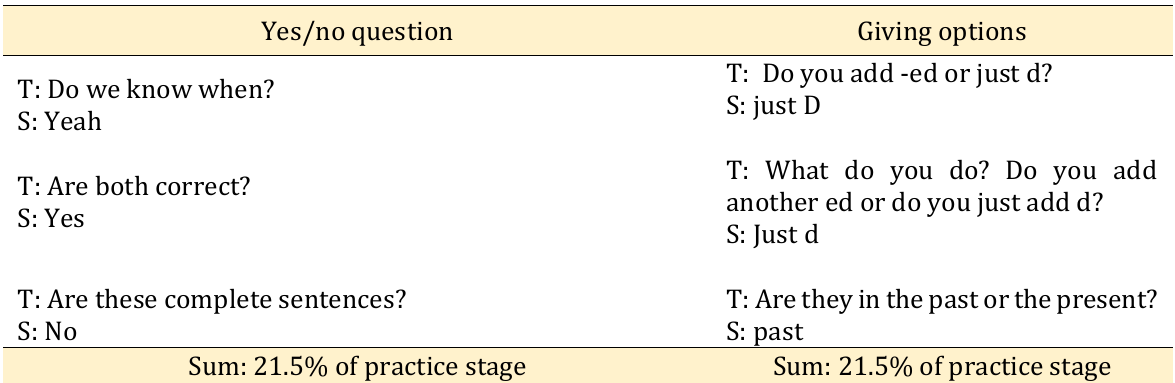
Table 4. Close-ended questions in the practice stage Yes/no question Giving